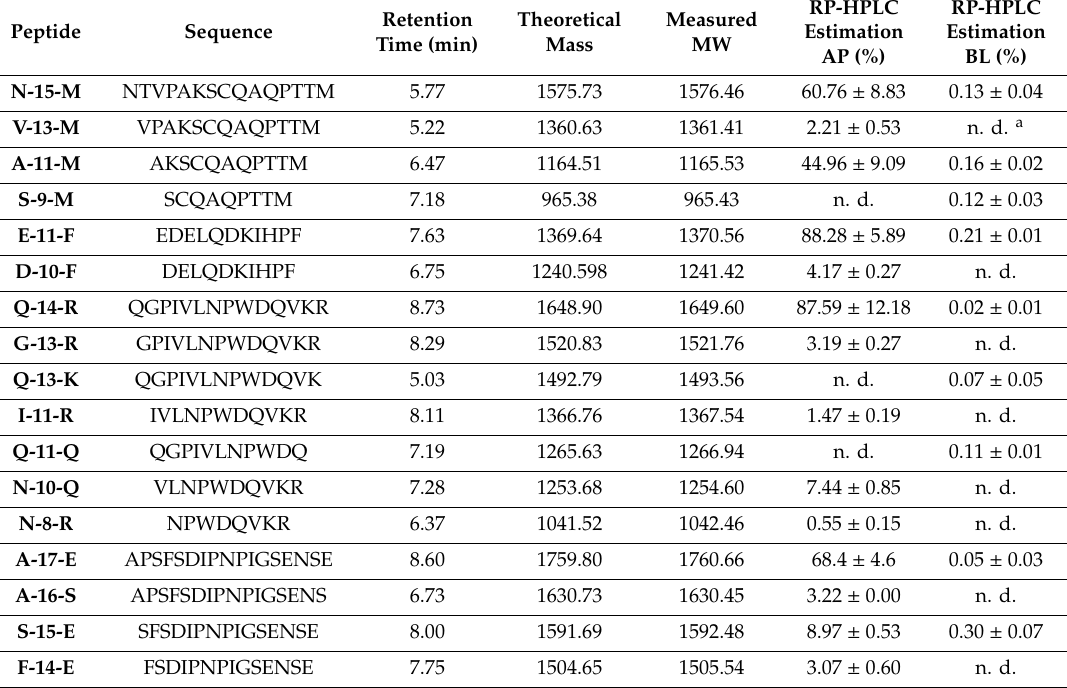
Table 5. Features of the studied peptides (bold) and their produced fragments, using RP-HPLC and MS